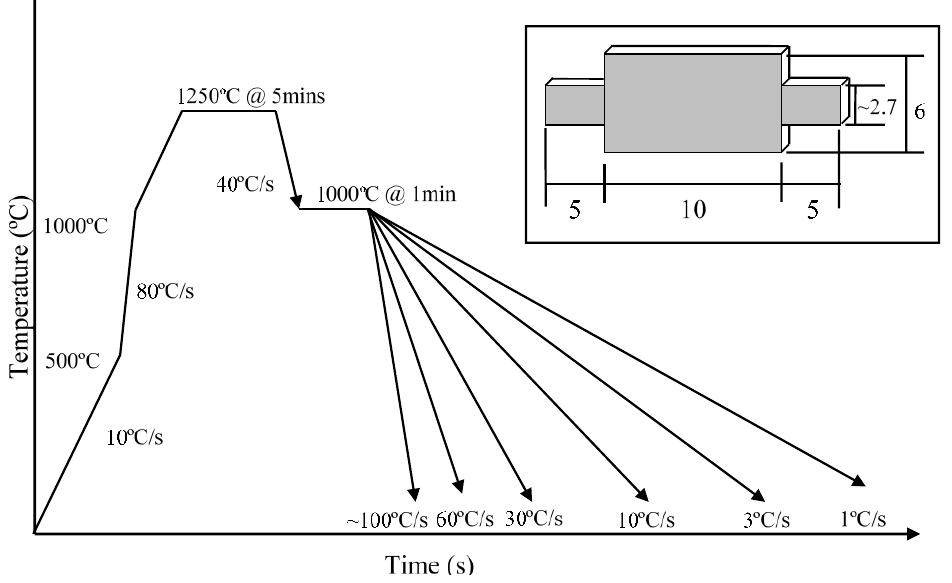
Figure 1. Schematic of dilatometer test program for determination of continuous cooling transformation (CCT) diagrams. Inset: Schematic of a typical thin strip dilatometer sample (dimensions in